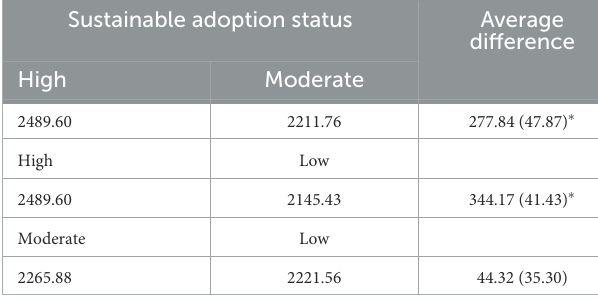
TABLE 5 Sustainable adoption impact on daily energy